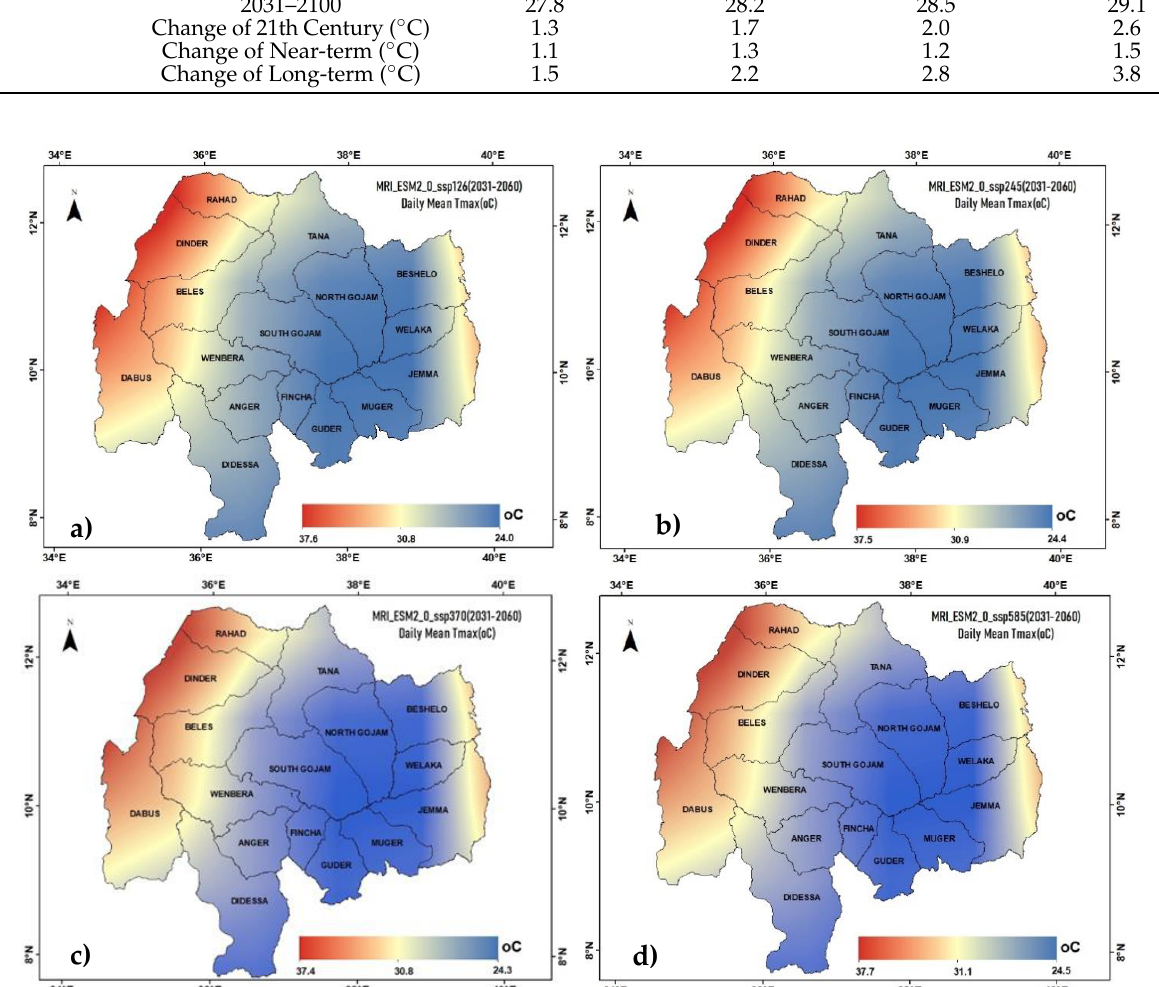
Figure 8. Spatial distribution of CMIP6-MRI-ESM2-0 model daily mean maximum temperature ( ◦ C) for ( a ) SSP126(24–37.6), ( b ) SSP245(24.4–37.5), ( c ) SSP370(24.3–37.4), and ( d ) SSP585(24.5–37.7) scenarios over the UBNB for the near-term projections (2031–2060). The spatial distributions of daily mean maximum temperature for four SSP scenarios looks identical but the range of the value are